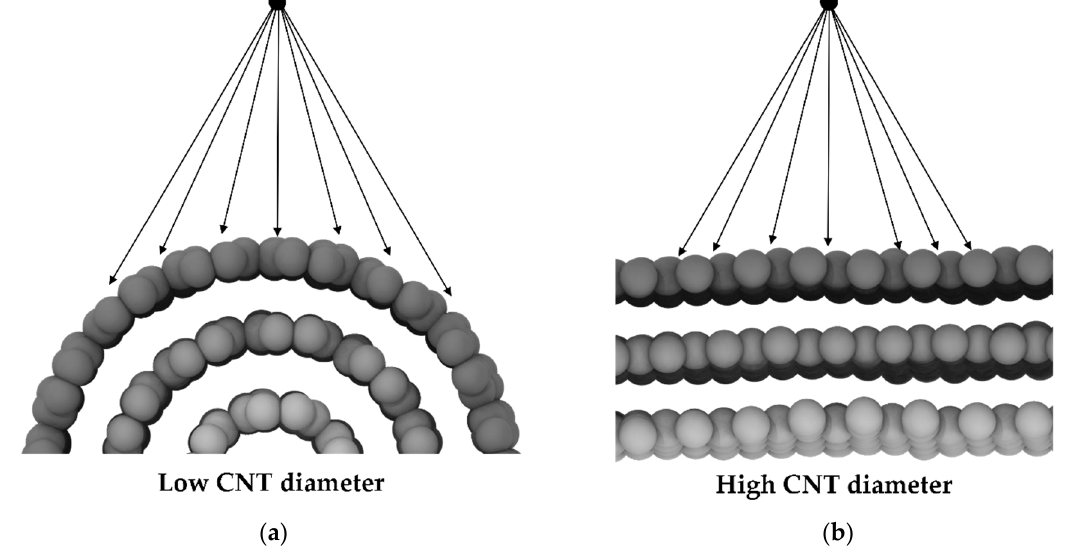
Figure 9. Possible effect of diameter on interface thickness: ( a ) Low CNT diameter; ( b ) high CNT diameter.